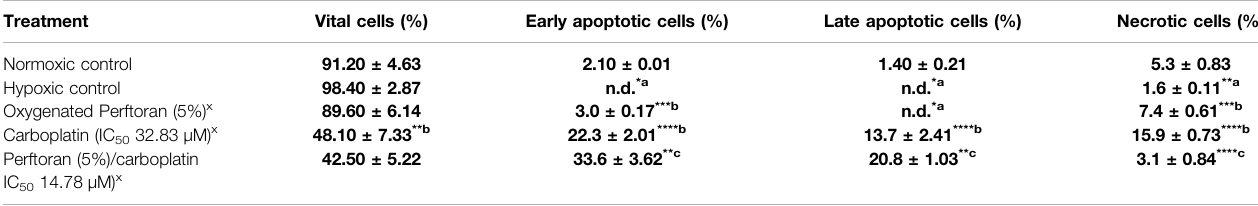
TABLE1| ModeofthecelldeathinA549cells,after differenttreatments,asassessedby fl uorescencemicroscopyanalysisaftercellstainingwithethidiumbromide/acridine orange ( n = 8). Results are expressed as cell population percentages; mean ± standard error.